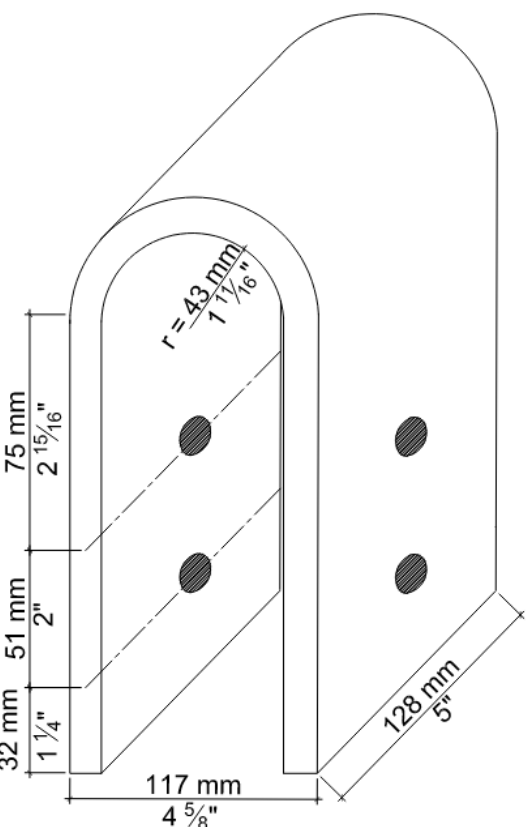
Figure 1. UFP details and dimensions of two-third scaled model as presented by the PRESSS program.